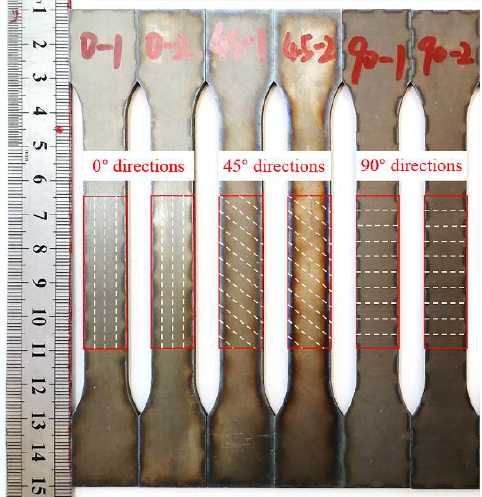
Figure 1. Tensile specimens.